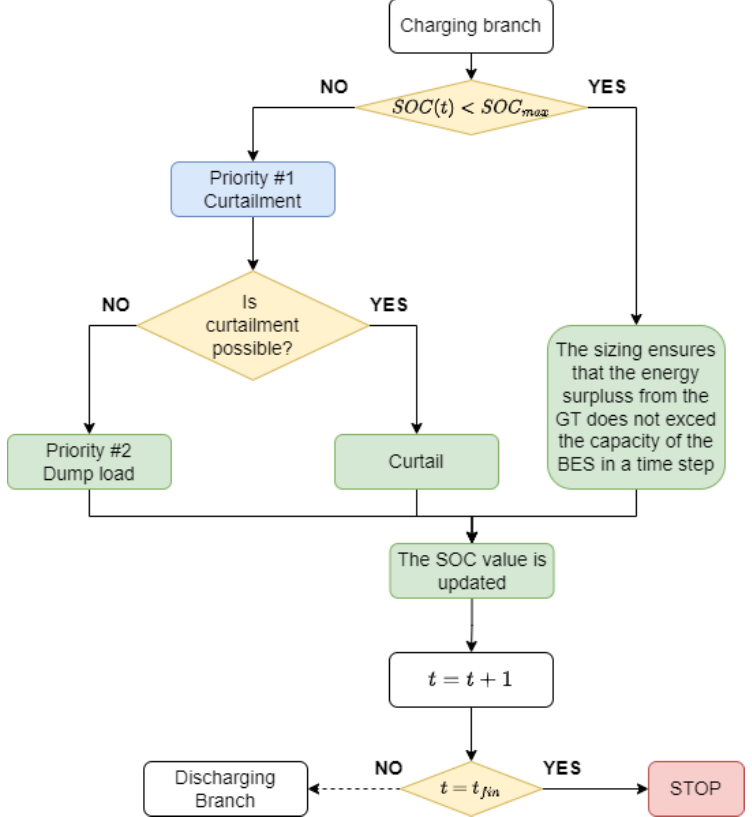
Figure 7. Rule-based flowchart of the proposed EMS left branch of Figure 6. Focus on the role that the management of WT-battery-GT plays in case of surplus from